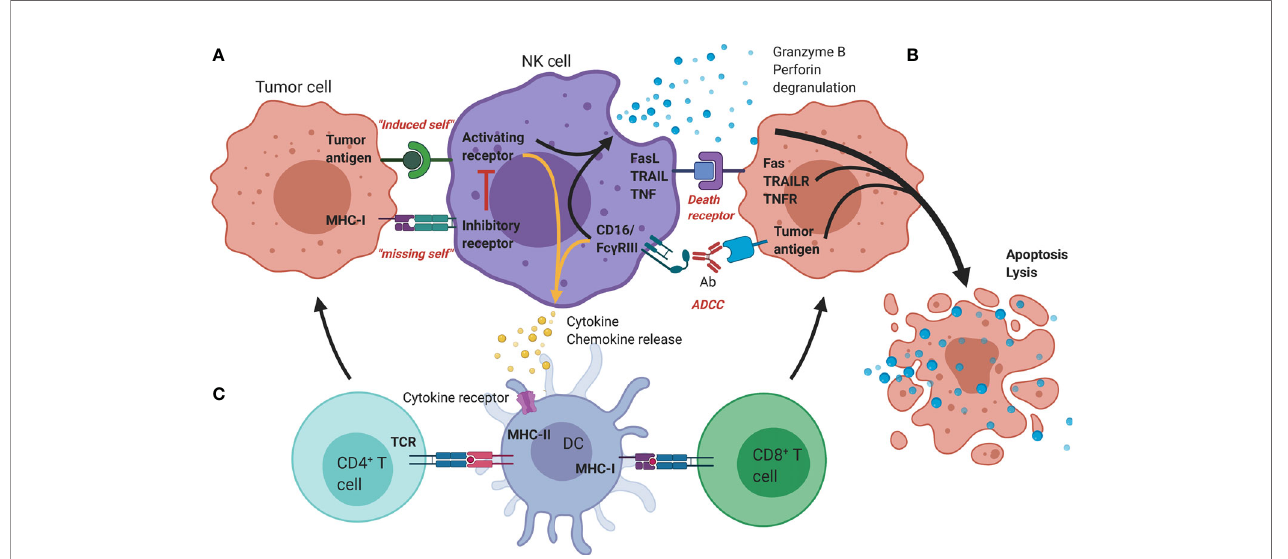
FIGURE 1 | Mechanisms of antitumor functionality of NK cells. (A) The represented ‘ activating ’ and ‘ inhibitory ’ NK cell receptors determine the NK cell activation through interaction with; (i) stress-induced tumor antigens or ligands for activating receptors acting towards an ‘ induced-self ’ response or (ii) MHC-I self-antigens or ligands for inhibitory receptors. (B) Additional tumor killing can be induced through either death receptors (FAS/TRAILR/TNFR), or antibody-dependent cellular cytotoxicity (Granzyme B/perforin degranulation). (C) Additional immune modulation by NK cells occurs through secretion of cyto-/chemokines that promote DC maturation and allow crosstalk with T cells, facilitating the induction of an adaptive immune response. Ab, Antibody; DC, Dendritic cell; FasL, Fas ligand; MHC, Major histocompatibility complex; NK, Natural killer; TCR, T-cell receptor; TNF(R), Tumor necrosis factor (receptor); TRAIL(R), TNF-related apoptosis-inducing ligand